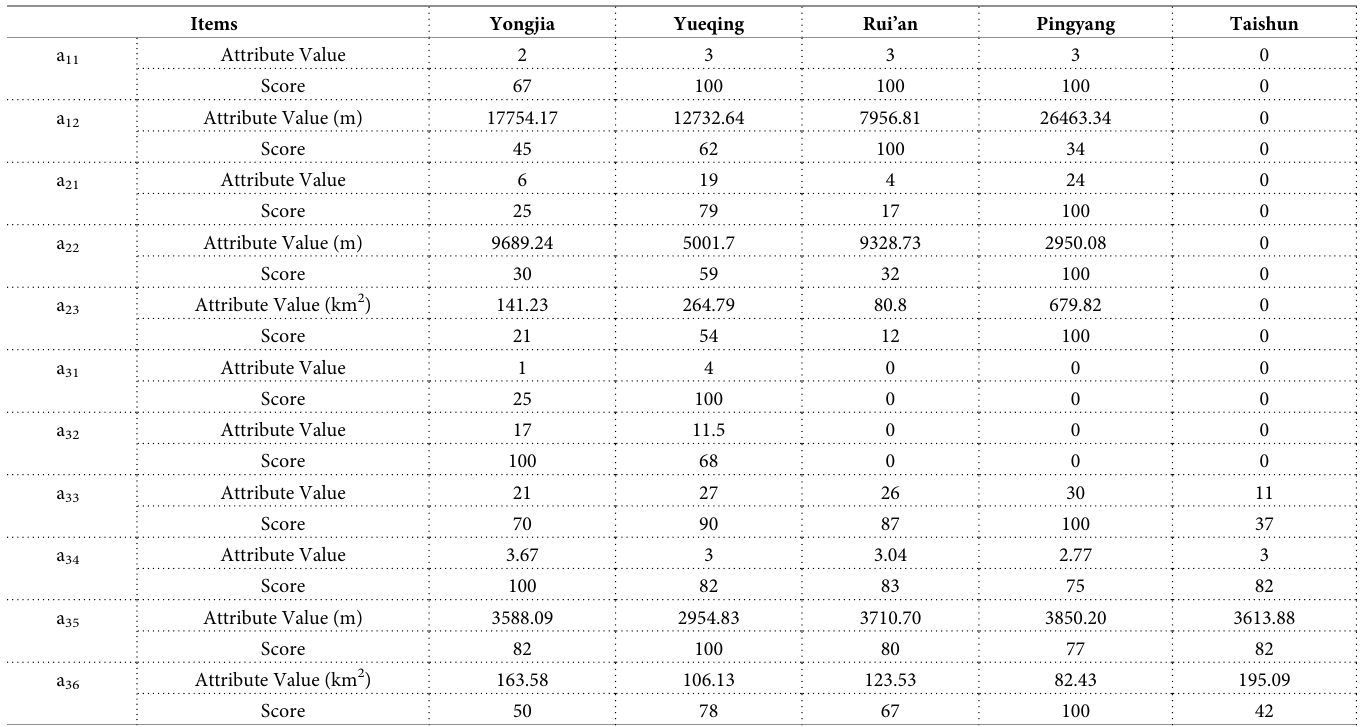
Table 10. Evaluation index scores statistics.